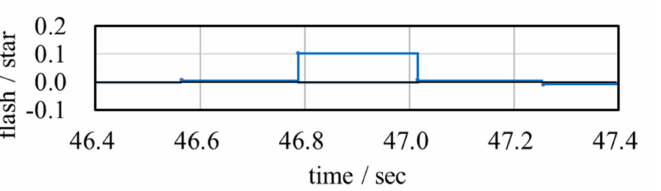
Figure 12. Light curve of Flash 2 as seen from Macei ó , in brightness ratio of the flash to the comparison